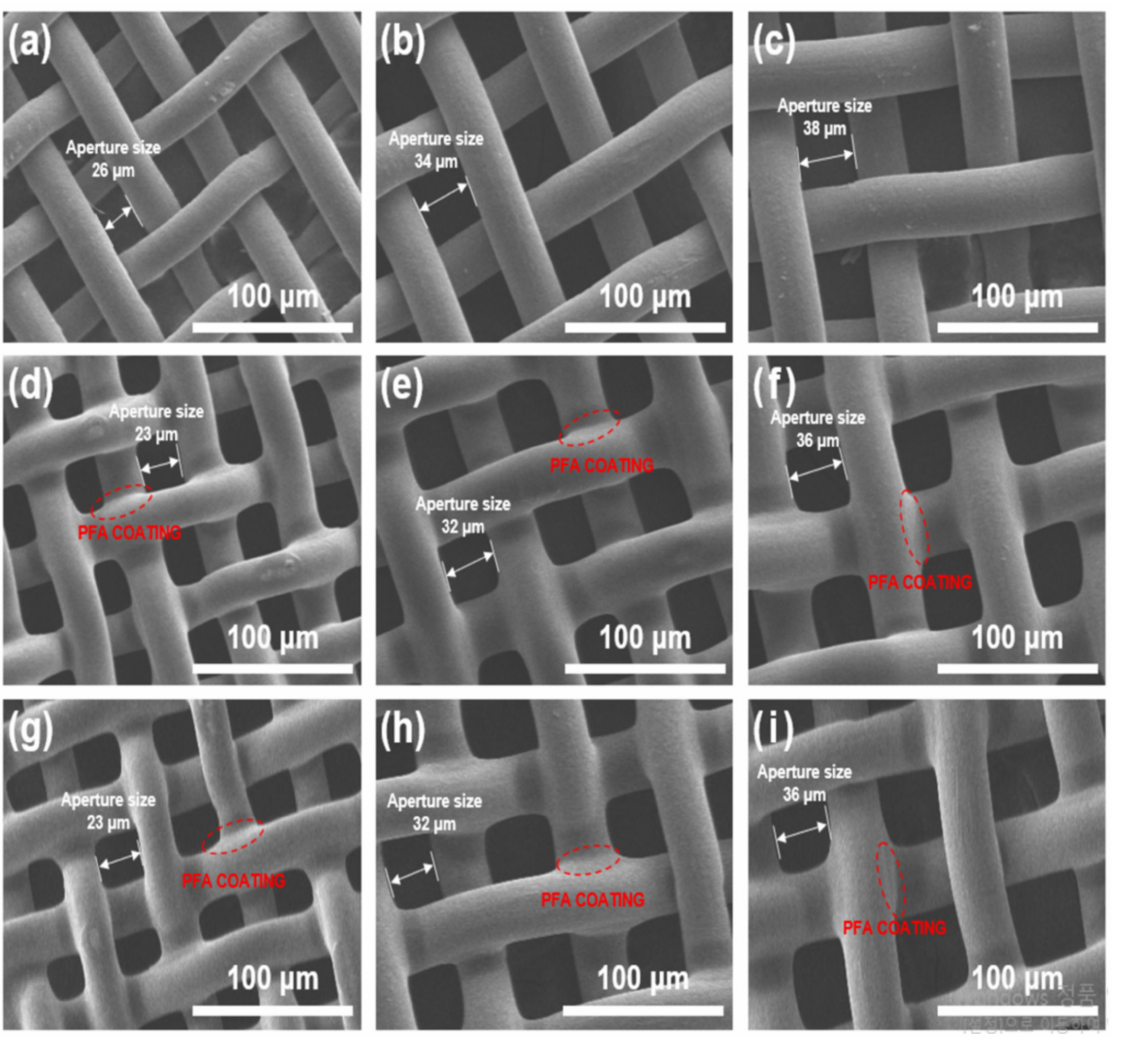
Figure 1. SEM images of the stainless-steel mesh ( a ) 26 µ m, ( b ) 34 µ m, ( c ) 38 µ m and PFA coated stain- less-steel mesh ( d ) 23 µ m, ( e ) 32 µ m, ( f ) 36 µ m and oxyfluorination treated PFA coated stainless-steel mesh ( g ) 23 µ m, ( h ) 32 µ m, ( i ) 36 µ